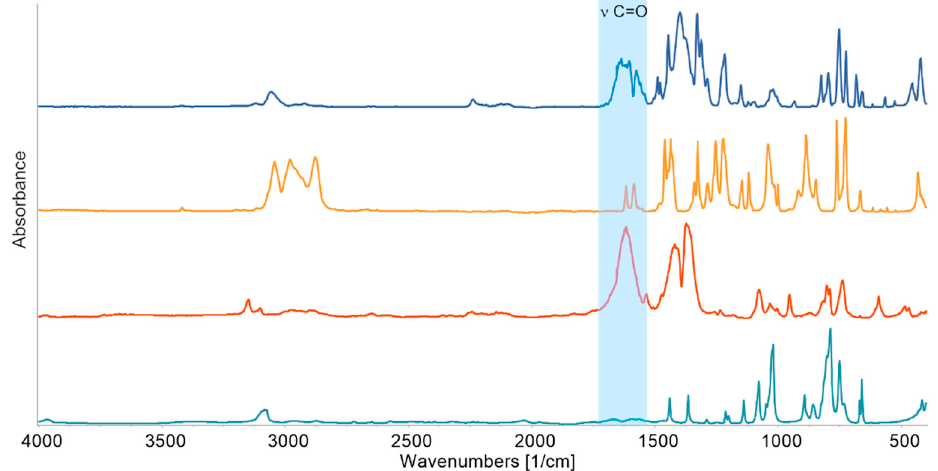
Figure 7. Stacked DRIFT (diffuse reflectance infrared Fourier transform) spectra of the reactions of 4 before (green trace) and after treatment with CO 2 (orange trace) as well as 5 before (yellow) and after treatment with CO 2 (blue) from bottom to top. The region for C − O vibrations is highlighted in blue.